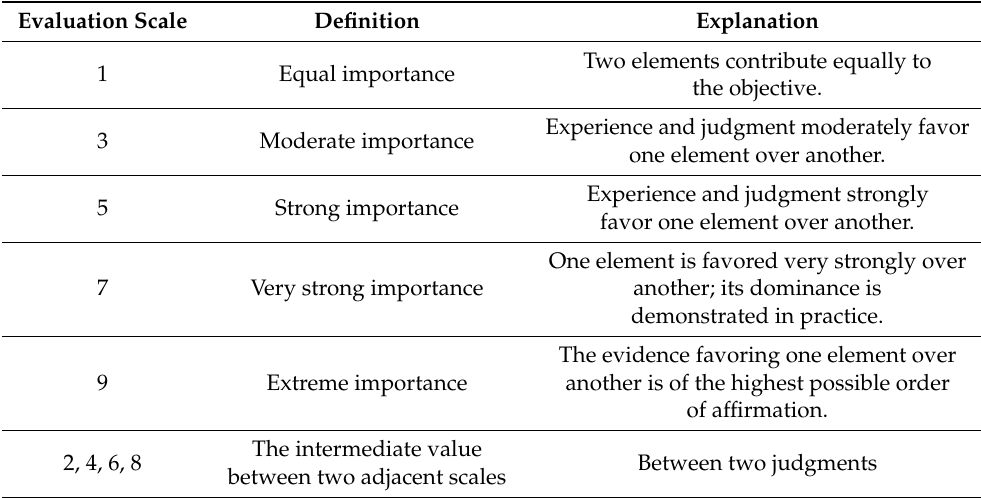
Table 1. Evaluation scale of the AHP and